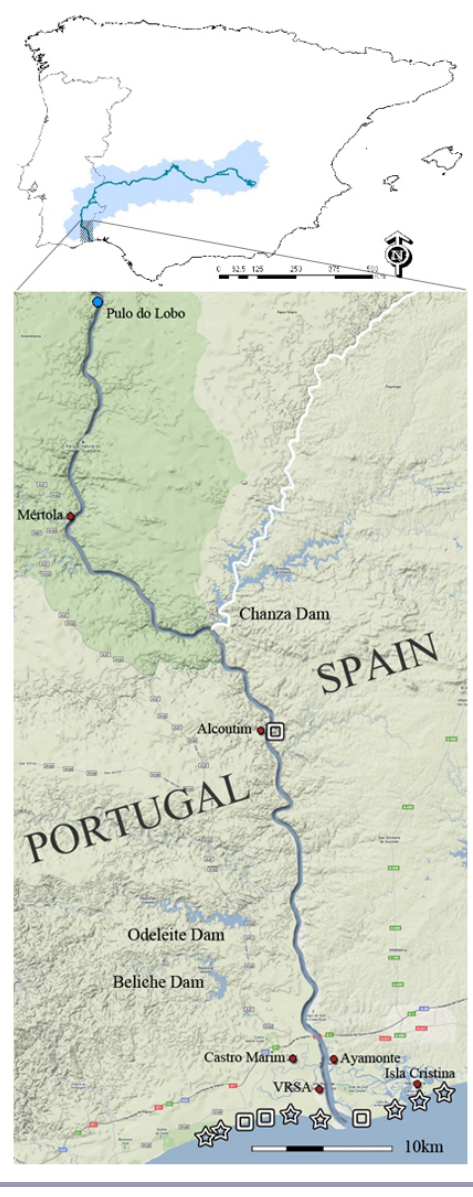
Fig. 1 . Location of the Guadiana river estuary (southwest Iberian Peninsula), including designated bathing areas inside the estuary and in the adjacent coastal zone. Inside the estuary, some undesignated areas are also used for bathing. The beaches with the Blue Flag Award (BFA) are represented by stars and the ones without it by squares. Data on BFA concerns 2011 season. The BFA is an eco-label that guarantees environmental quality of the beaches awarded. The major urban centers are represented by red dots. The blue dot highlights Pulo do Lobo sampling